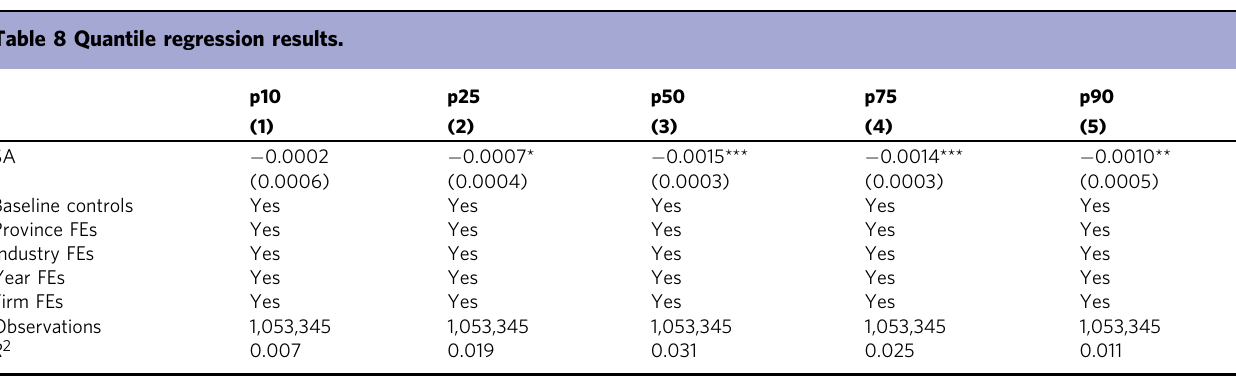
Table 8 Quantile regression